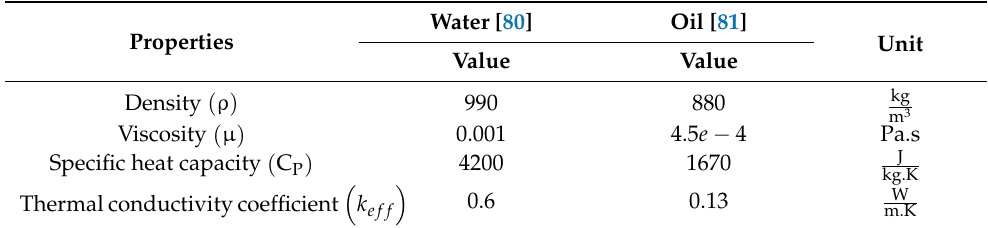
Table 2. The characteristics of water and oil at a constant temperature.